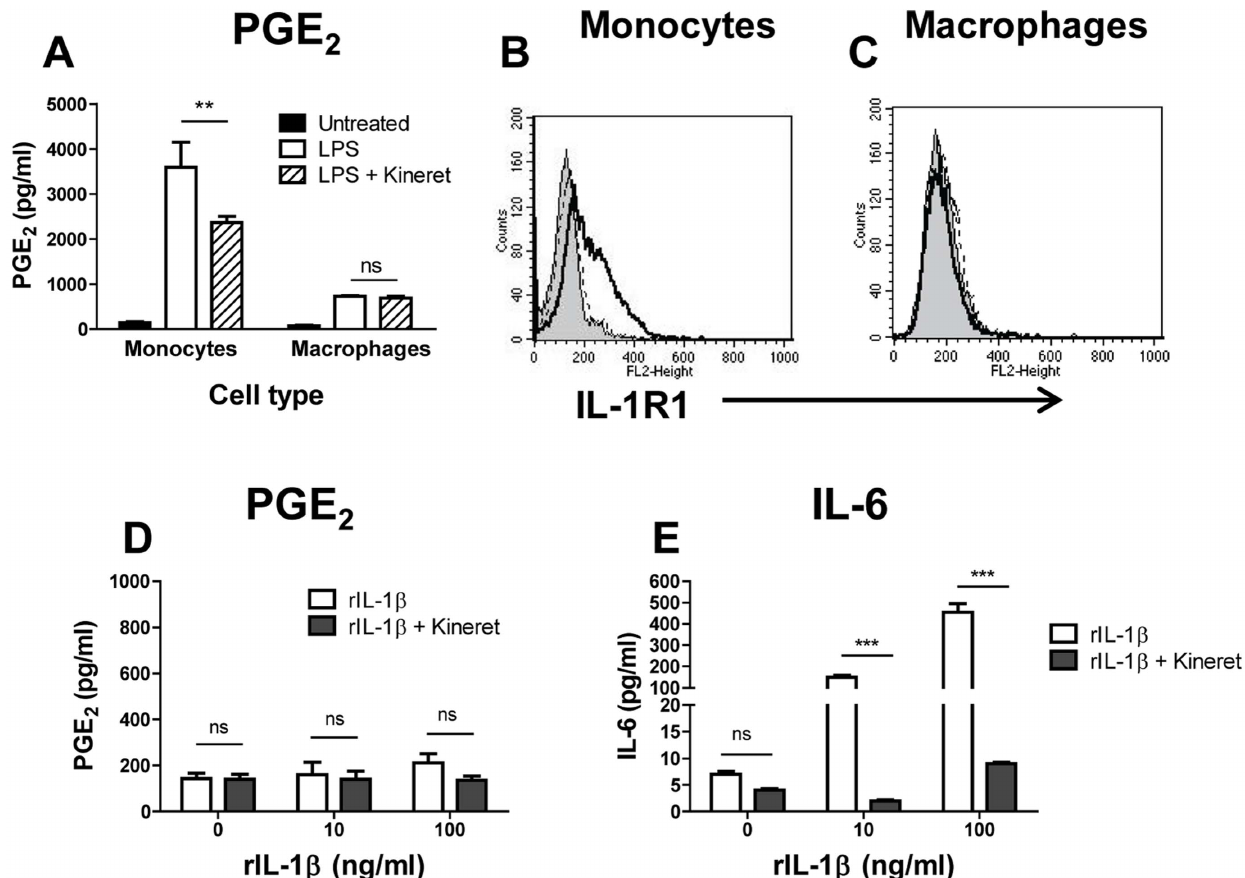
Figure 4. Different contributions of rIL-1 b IL-1R signaling to IL-6 vs. PGE 2 production in human monocytes and macrophages. (A) Monocytes and differentiated macrophages were left untreated (solid bars) or were incubated with LPS alone at 20 ng/ml or with LPS in the presence of the IL-1R inhibitor Kineret (open and striped bars, respectively). Cell culture supernatants were assayed for PGE 2 . (B–C) The expression level of IL- 1R1 was determined by FACS analysis on monocytes (B) and macrophages (C) untreated (dashed lines) or following activation with LPS at 20 ng/ml overnight (solid lines); filled histograms in panels B and C show staining with IgG-PE isotype control antibody. The Delta Mean Fluorescence Intensity ( D MFI) was calculated by subtracting the isotope control MFI from the experimental values. The IL-1R1 D MFI for untreated and LPS-activated cells was 13.2 6 6.4 and 73.2 6 8.1 for monocytes (B) and 13.0 6 3.3 and 5.2 6 5.5 for macrophages (C), respectively, n=3. Histograms show results from one representative experiment, each measuring at least 10,000 events. (D–E) Monocytes were incubated with human rIL-1 b at 0, 10 or 100 ng/ml in the absence or presence of Kineret for 18 h (open and solid bars, respectively). Cell culture supernatants were assayed for PGE 2 (D) or for IL-6 (E). The data in A, D, and E are shown as means 6 STDEV for triplicate wells in the PGE 2 and IL-6 and assay. This is representative of three experiments with similar results, ***p # 0.001, **p # 0.01; ns, not significant.